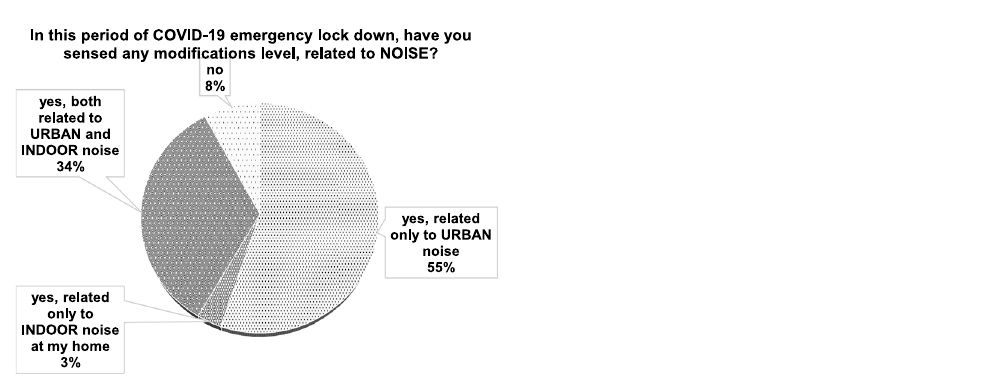
Figure 5. Italian results: general